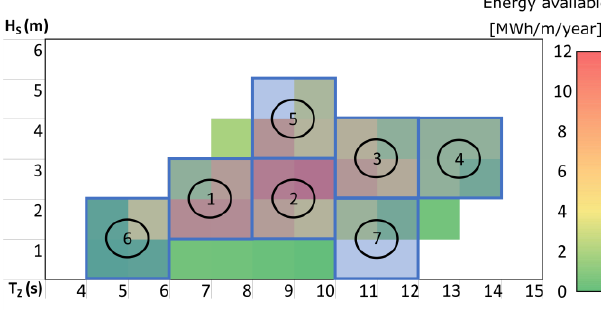
Fig. 2. Resource matrix at the site and seven selected sea states.